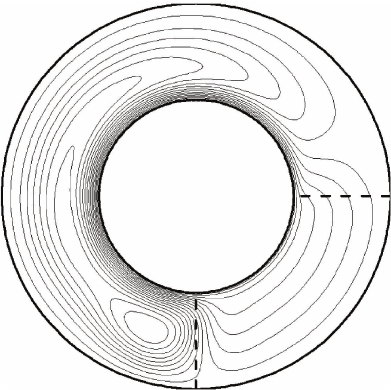
Figure 10: Distributions of the contours of stream function for a quarter-circular external magnetic fluids of Ha (cid:8) 30 (cid:2)Δ ψ (cid:8) 0 . 0025 (cid:3) .